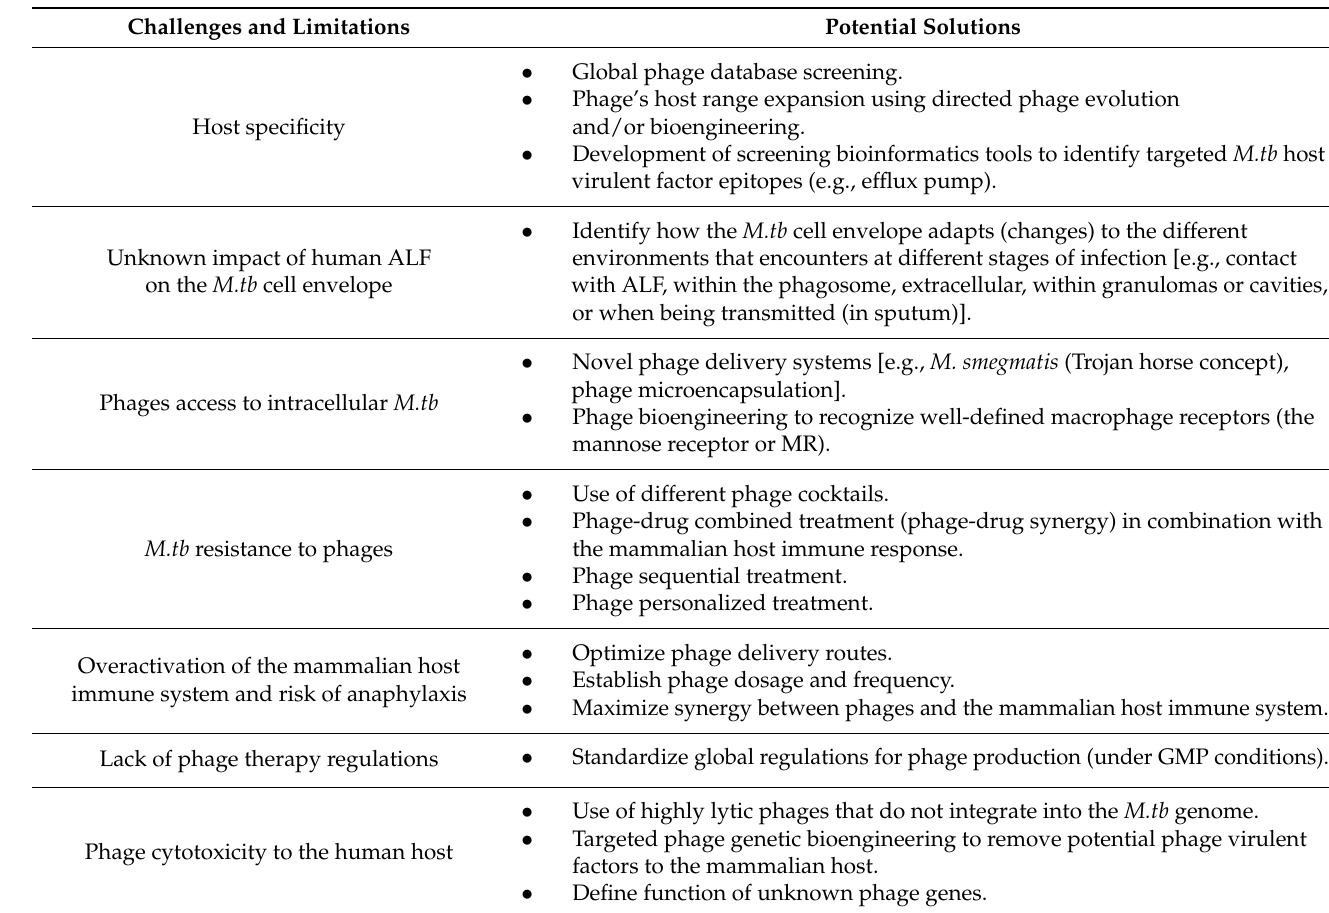
Table 2. Phage therapy challenges in drug-resistant TB